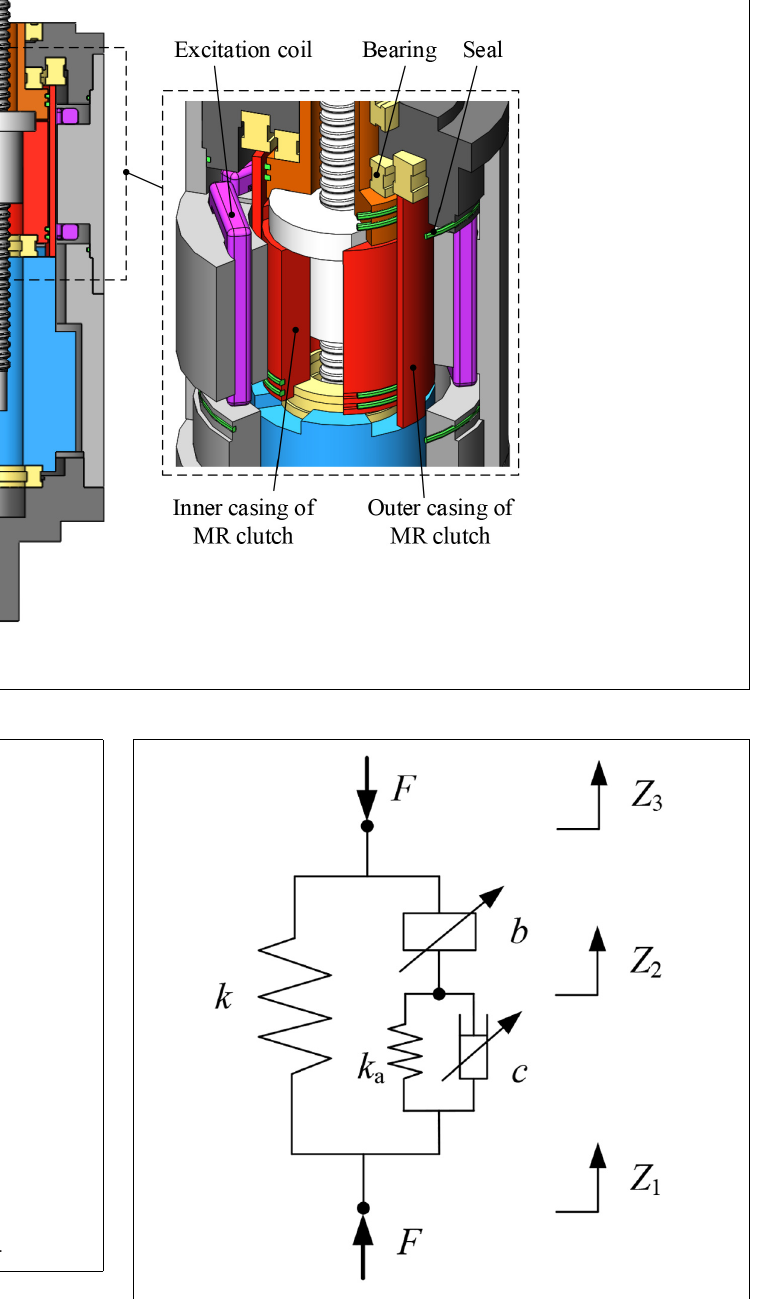
FIGURE 4 | Mechanical model of the integrated